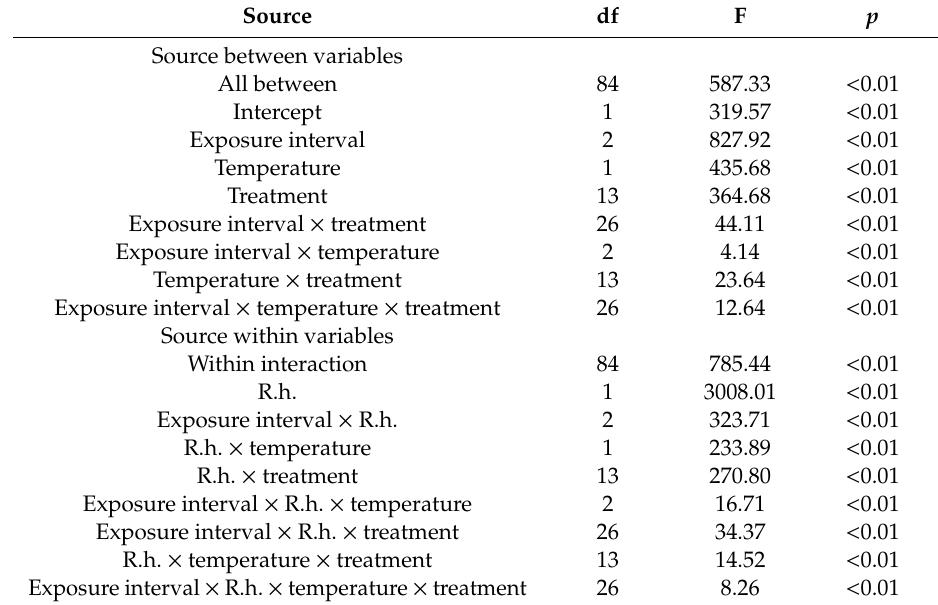
Table 5. Repeated measures ANOVA of the main e ff ects and associated interactions for the mortality of rice weevil adults in bioassay 2 (df =